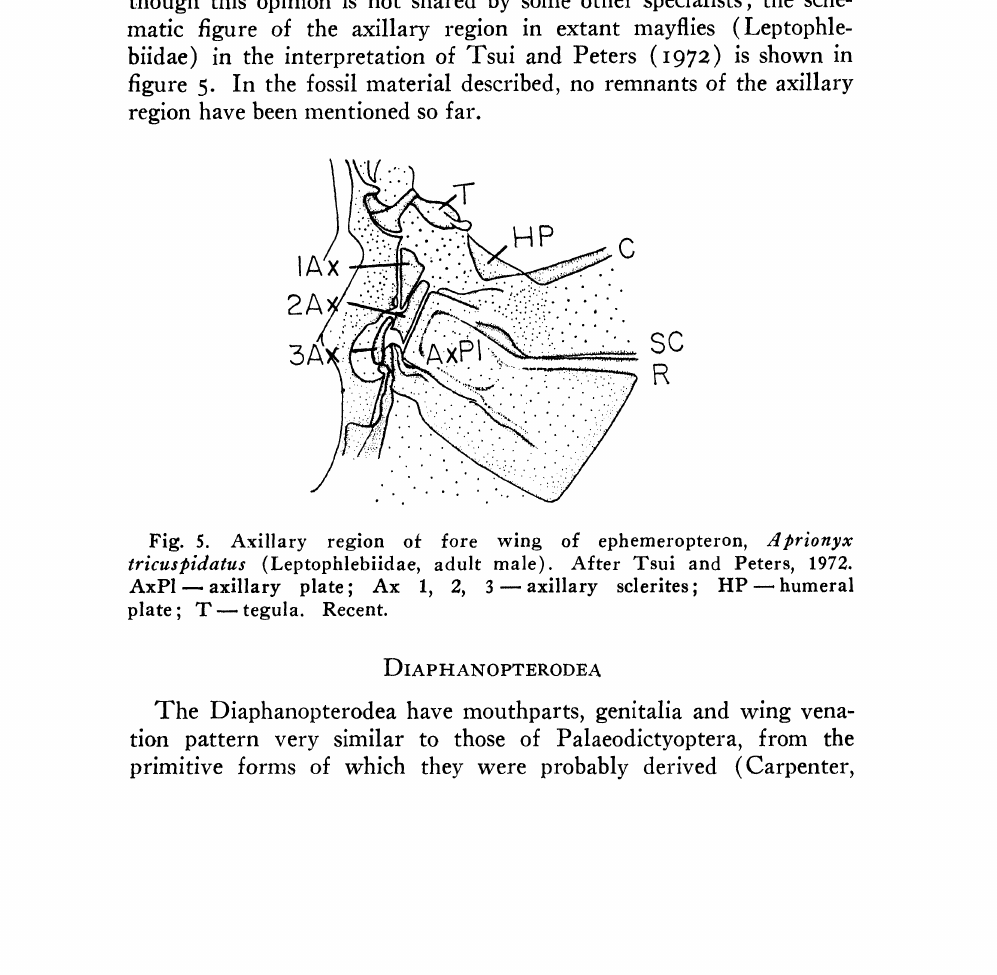
Fig. 5. Axillary region of fore wing of ephemeropteron, Aprionyx tricuspidatus (Leptophlebiidae, adult male). After Tsui and Peters, 1972. AxP1---axillary plate; Ax 1, 2, 3--axillary sclerites; HP humeral plate; T--- tegula. Recent.